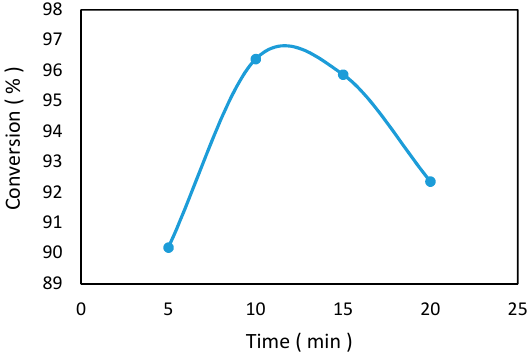
Figure 6. Effect of time on biodiesel production.